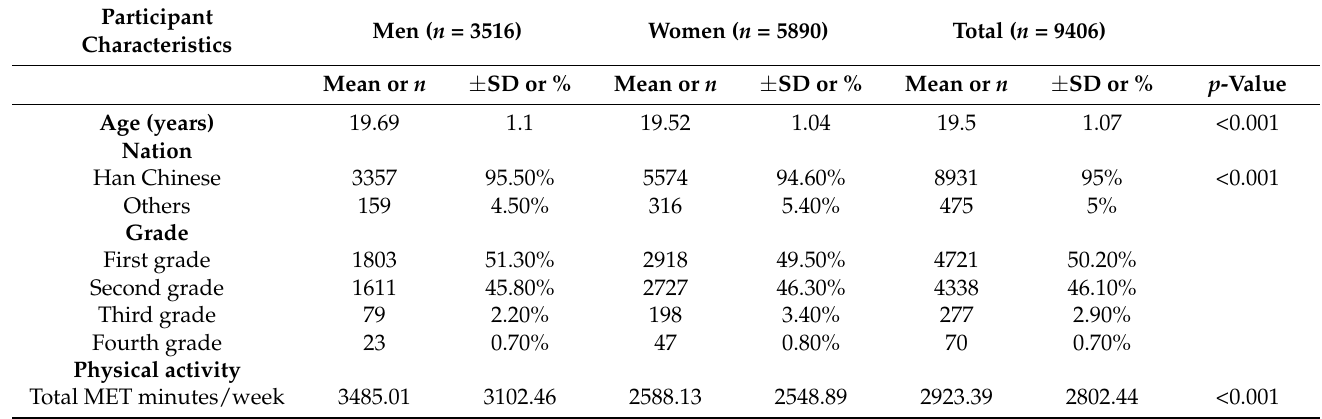
Table 1. Participants’ demographics and